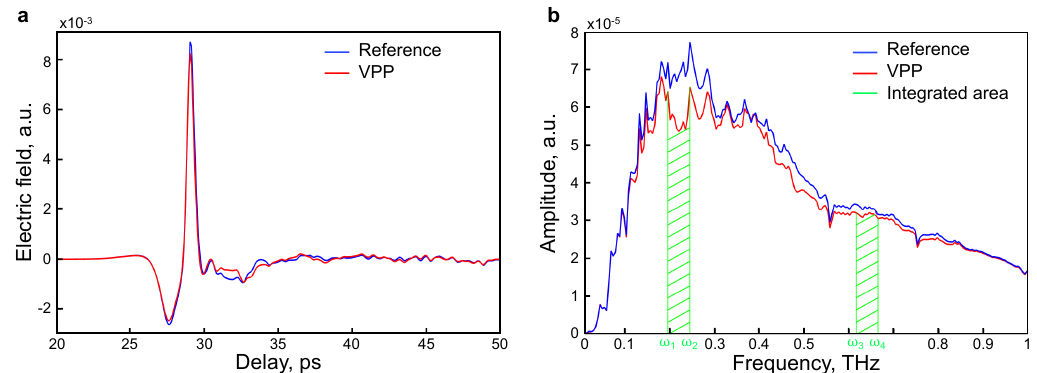
Figure 2. ( a ) time-domain spectra of VPP and its reference; ( b ) transmitted amplitude THz spectra of a VPP and a substrate. Representation of dual-wavelength THz spectroscopy (DWTS) principle: with transmitted amplitude spectrum of the VPP and a substrate, where we can see the transmission dip from ω 1 to ω 2 and no difference from ω 3 to ω 4